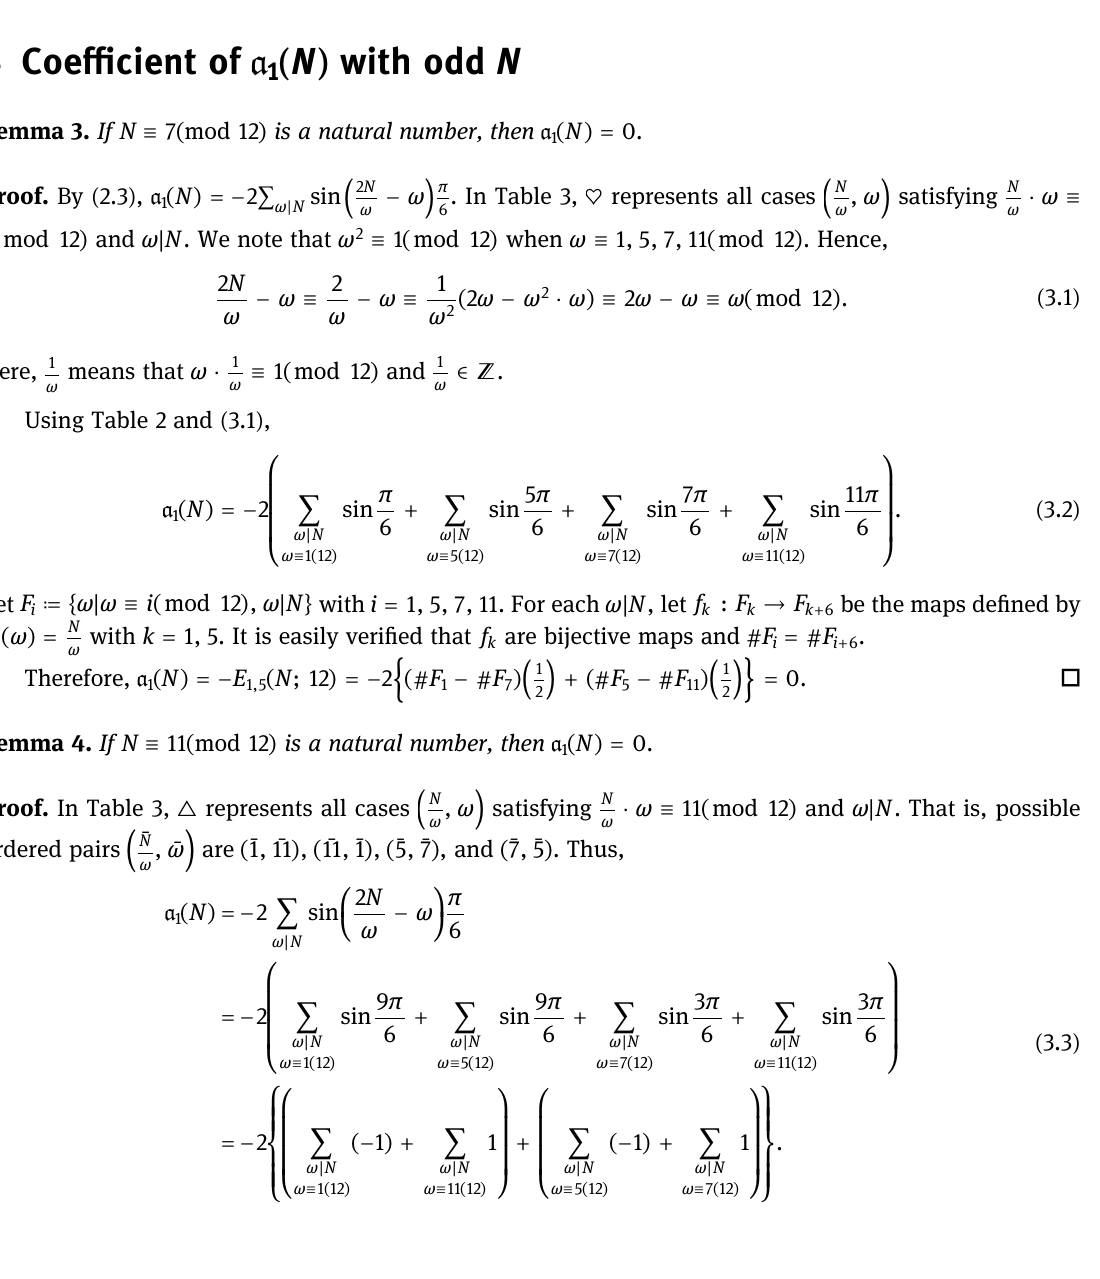
Table 4: In fi nite product forms of E N ˆ ( ) and e N ˆ ( ) In fi nite product